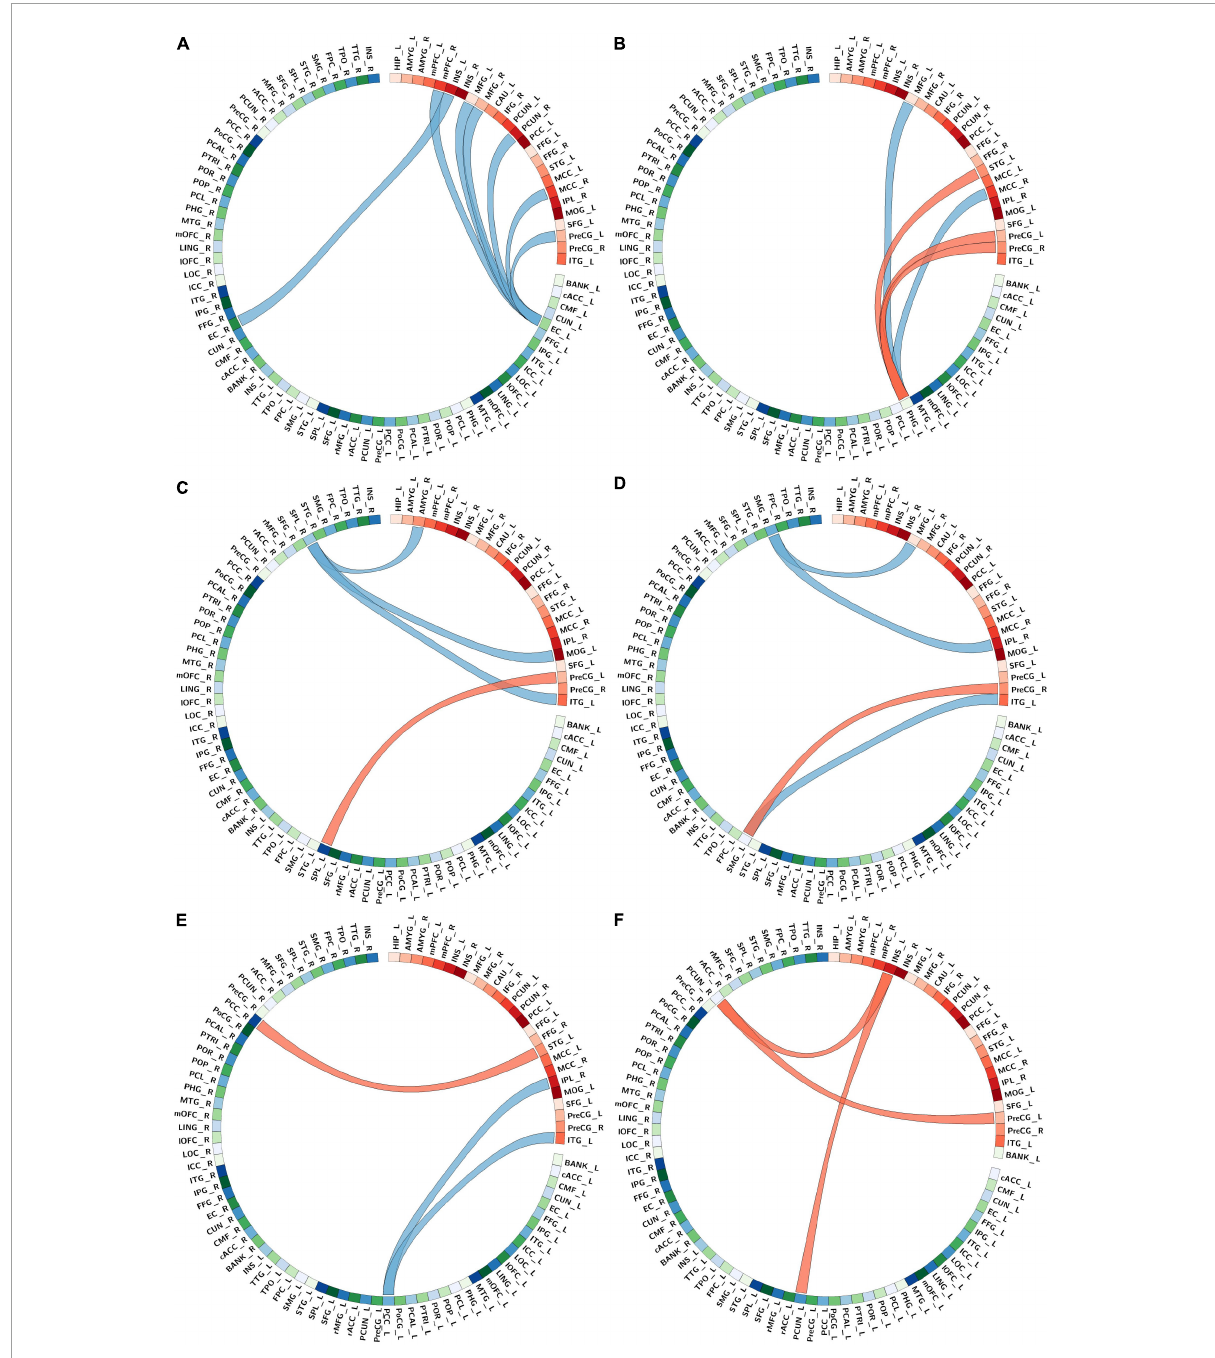
FIGURE3 The main altered connectivity network profiles in structural covariance between post-traumatic stress disorder (PTSD) and none-PTSD group, centered on six key regions. (A) The connectivity network profiles of the right medial prefrontal cortex (mPFC), right precuneus, right mid-cingulate cortex (MCC), left insula, left precentral gyrus, and bilateral medial frontal gyrus (MFG) with the bilateral entorhinal. Bands with red and blue represent increased and decreased covariance, respectively. Ring color with gradient red and green-blue represents areas in the collected abnormal seeds and the whole-brain cortical surface, respectively. And the Desikan-Killiany atlas (thirty-four regions/per hemisphere) underlay the whole-brain cortical parcellations; (B) the connectivity network profiles of the left MFG, left superior temporal gyrus (STG), right MCC, and bilateral precentral gyrus with the left parahippocampal; (C) the connectivity network profiles of the right amygdala, left middle occipital gyrus (MOG), left precentral gyrus, and left inferior temporal gyrus (ITG) with bilateral superior parietal gyrus; (D) the connectivity network profiles of the left MFG, right inferior parietal lobule (IPL), right precentral gyrus, and left ITG with bilateral supramarginal gyrus; (E) the connectivity network profiles of the left STG, right IPL, and left ITG with the bilateral posterior cingulated cortex; (F) the connectivity network profiles of the left insula and precentral gyrus with the bilateral precuneus bilateral. As for abbreviations on the drawing, please refer to Supplementary Table 1